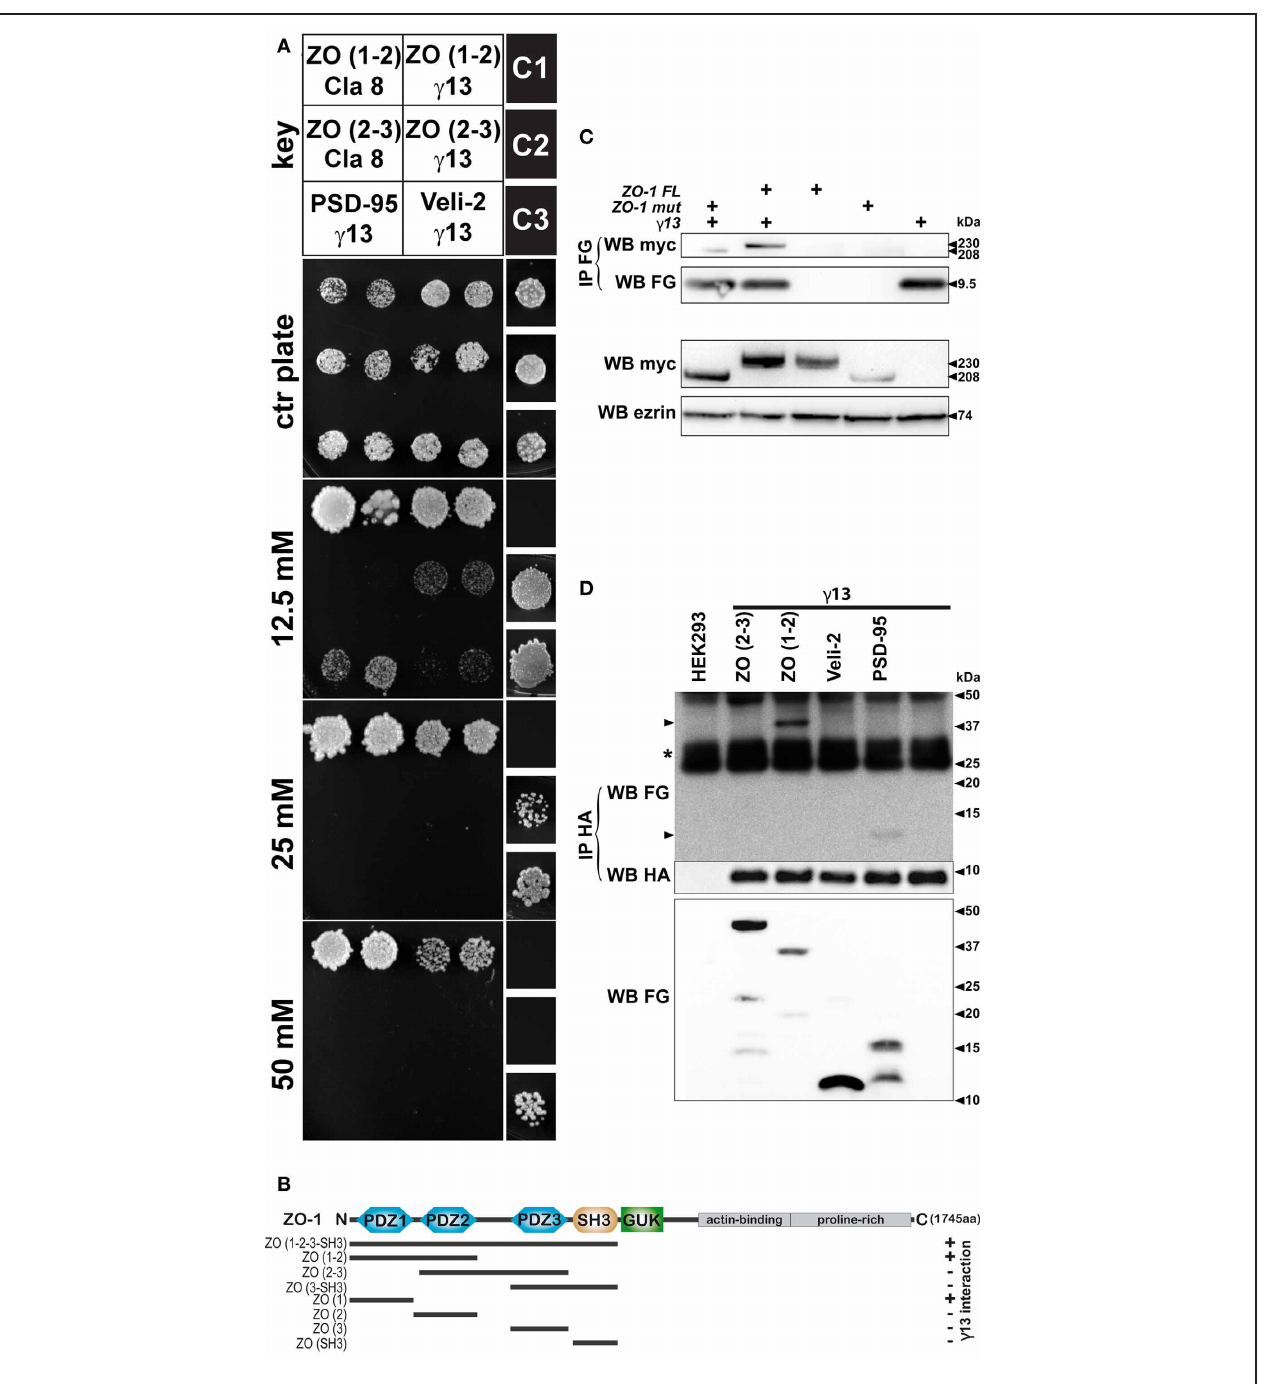
FIGURE 3 | Physical interaction between heterologously expressed G γ 13 and ZO-1. (A) To test the strength of the interaction between the proteins assayed Mav203 yeasts cells were co-transformed with different combinations of bait and prey plasmids (see key). Interaction was scored on minimal medium plates lacking His, Leu, and Trp but containing increasing concentrations of 3-AT (0–50mM) a competitive inhibitor of the enzyme involved in histidine biosynthesis. Titration of the strength of the interaction is established by growth potential and compared to weak (C1), moderate (C2) and strong (C3) interaction controls provided by the manufacturer. The construct encompassing the first 2PDZ domains of ZO-1 [ZO (1–2)] interacts with G γ 13 ( γ 13) to a similar extend as with the c-terminal tail of claudin 8